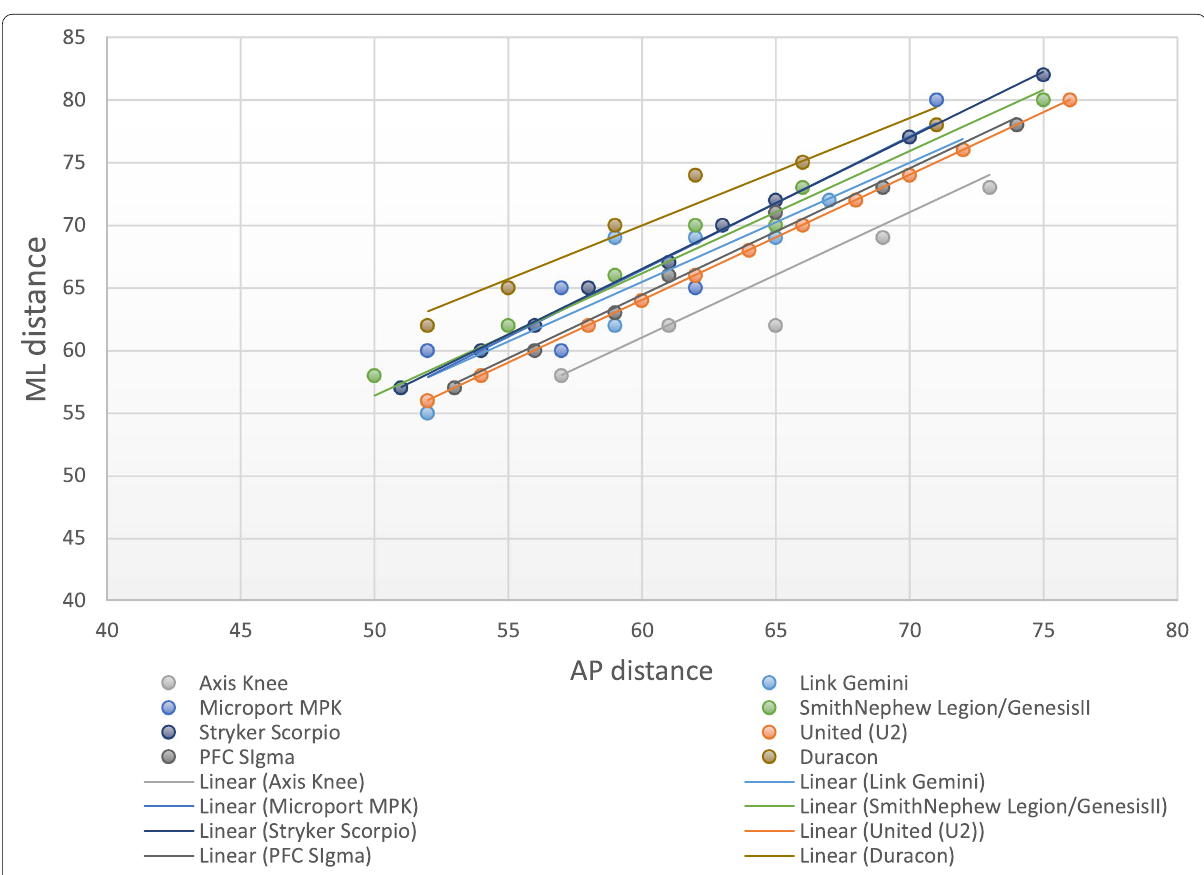
Fig. 2 Anteroposterior and mediolateral dimensions of TKR femoral prostheses in the Philippine and Asian